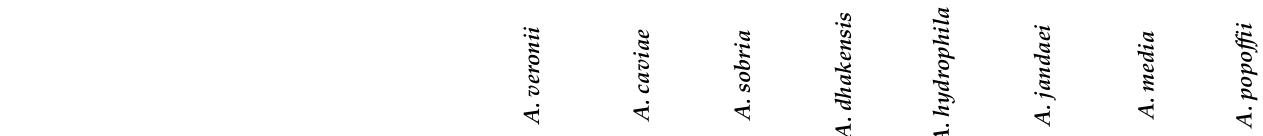
Table 2. Different sources of isolation of Aeromonas spp.